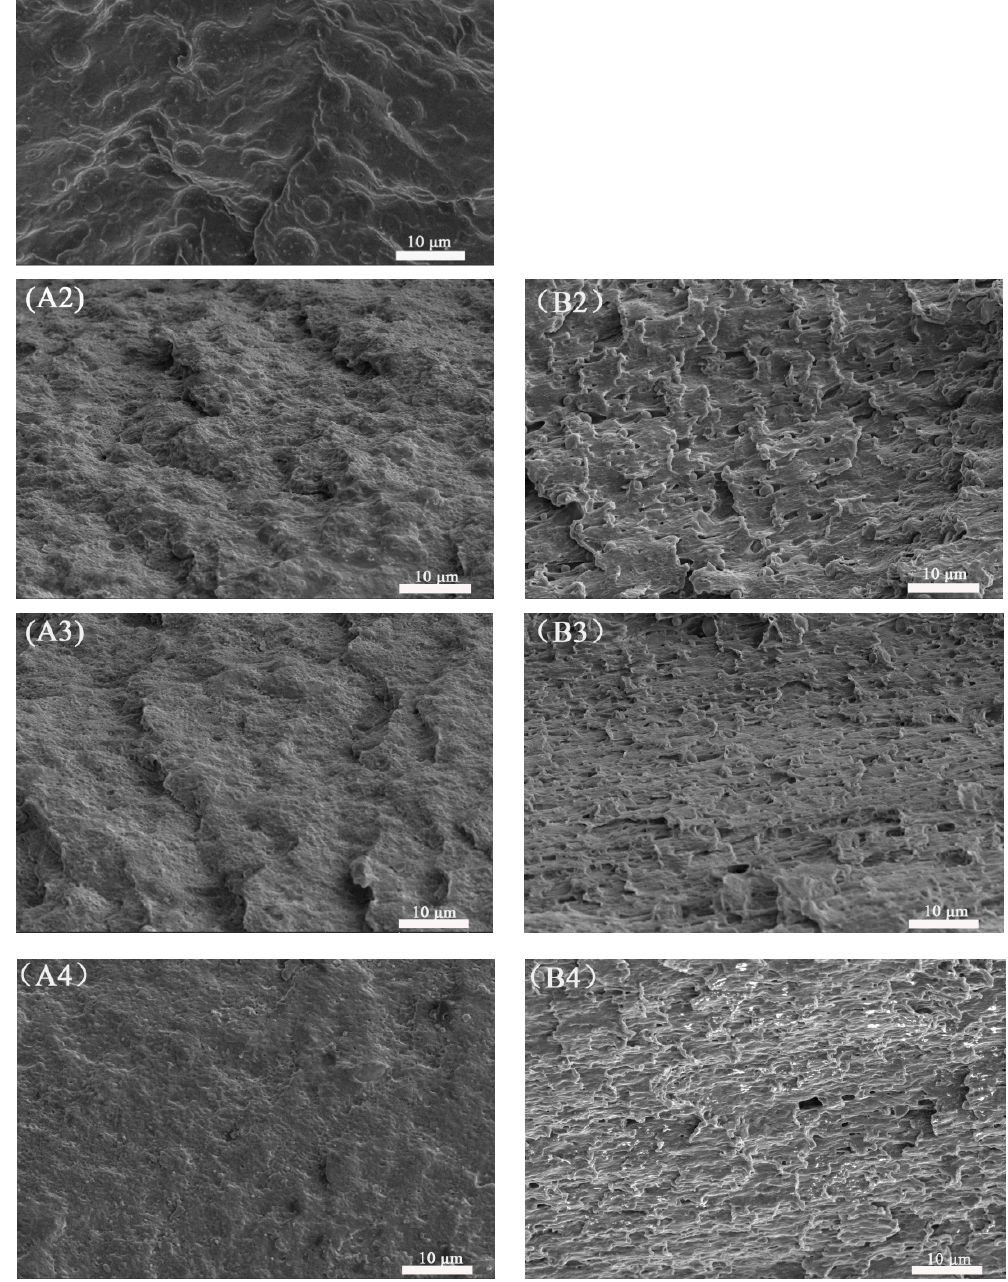
Figure 13. SEM images (×3000) of cryofractured surfaces of PETG/PGA/ADR tensile fractured specimens along tensile direction. (A) unstretched part (A1—65/35/0; A2—65/35/0.3; A3—65/35/0.6; A4—65/35/0.9); (B) stretching-oriented part (B2—65/35/0.3; B3—65/35/0.6; B4—65/35/0.9).